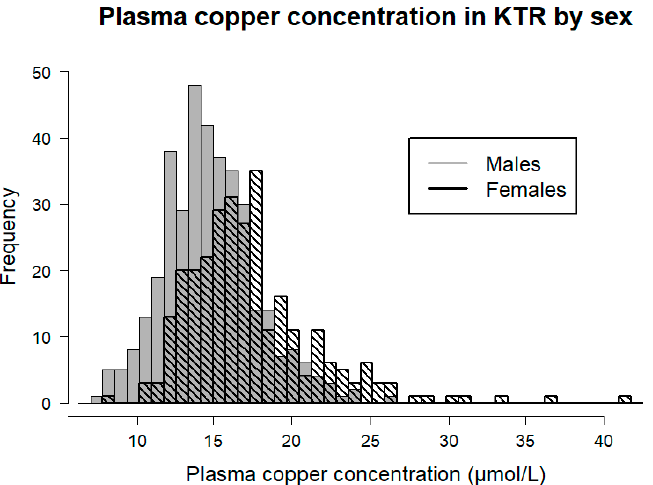
Figure 1. Sex-stratified plasma copper concentration in KTR. Median plasma copper concentration was 14.64 [12.75–16.37] µmol/L for male KTR and 16.68 [14.64–19.20] µmol/L for female KTR. Plasma copper concentration was significantly different among males and females according to the Mann-Witney U test ( p < 0.001). KTR, kidney transplant recipients.